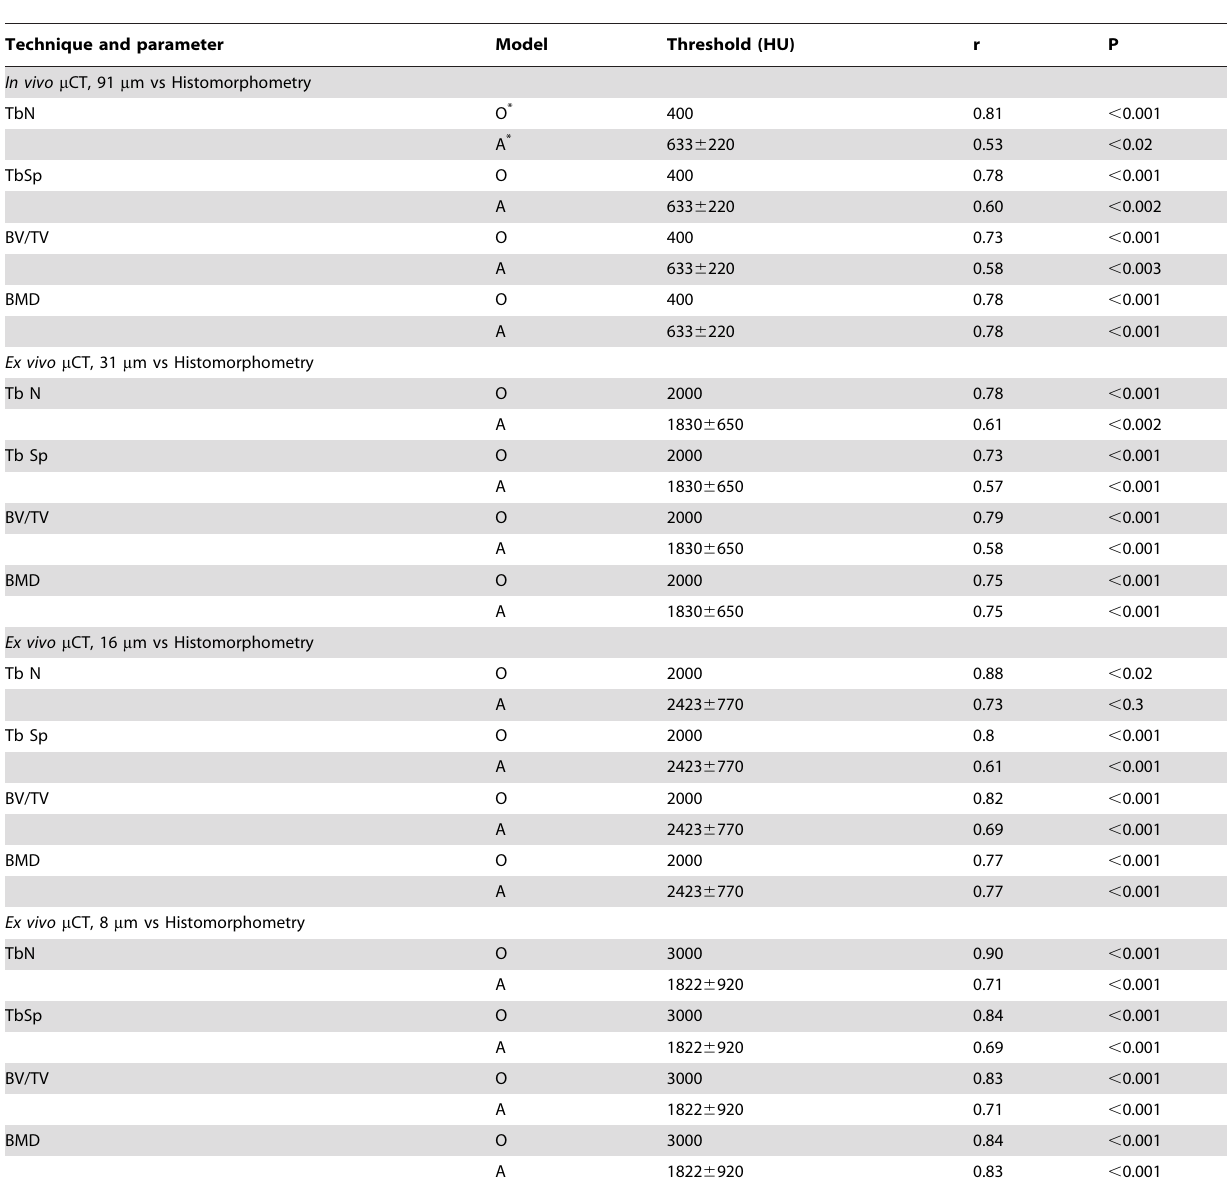
Table 2. Correlations between metaphyseal BMD and bone structural parameters derived by bone histomorphometry, in vivo m CT, or ex vivo specimen m CT 10 weeks after tumor